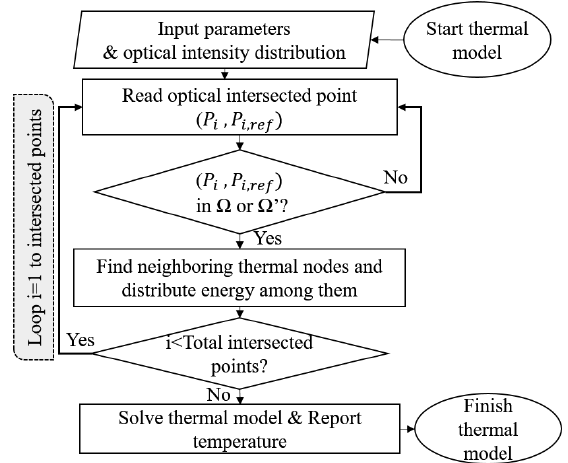
Figure 8. Flowchart of the implemented thermal